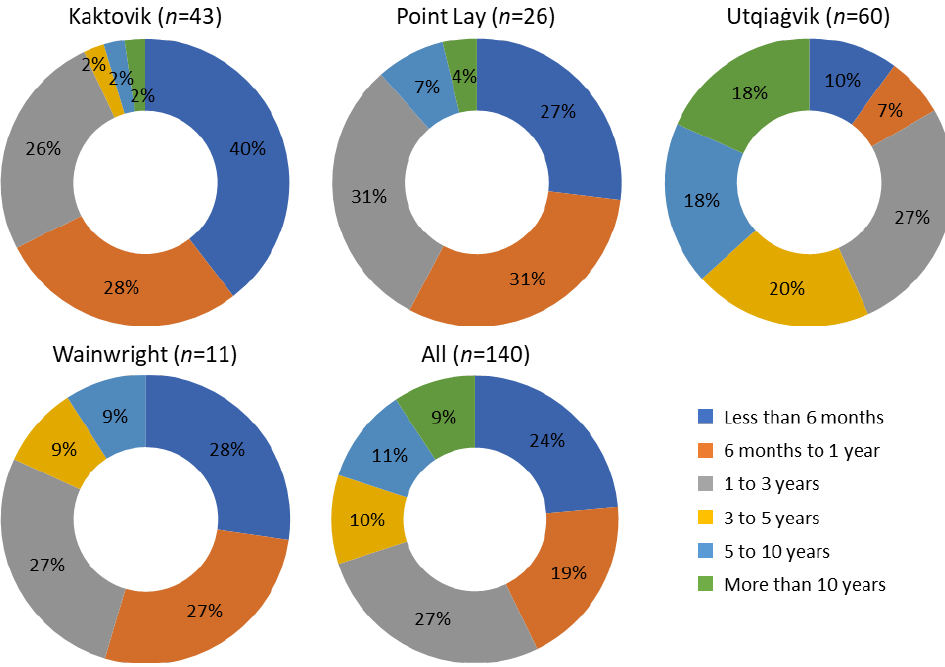
Figure 4. Observed time periods of permafrost-thaw-induced ground surface changes. n is the sample size.